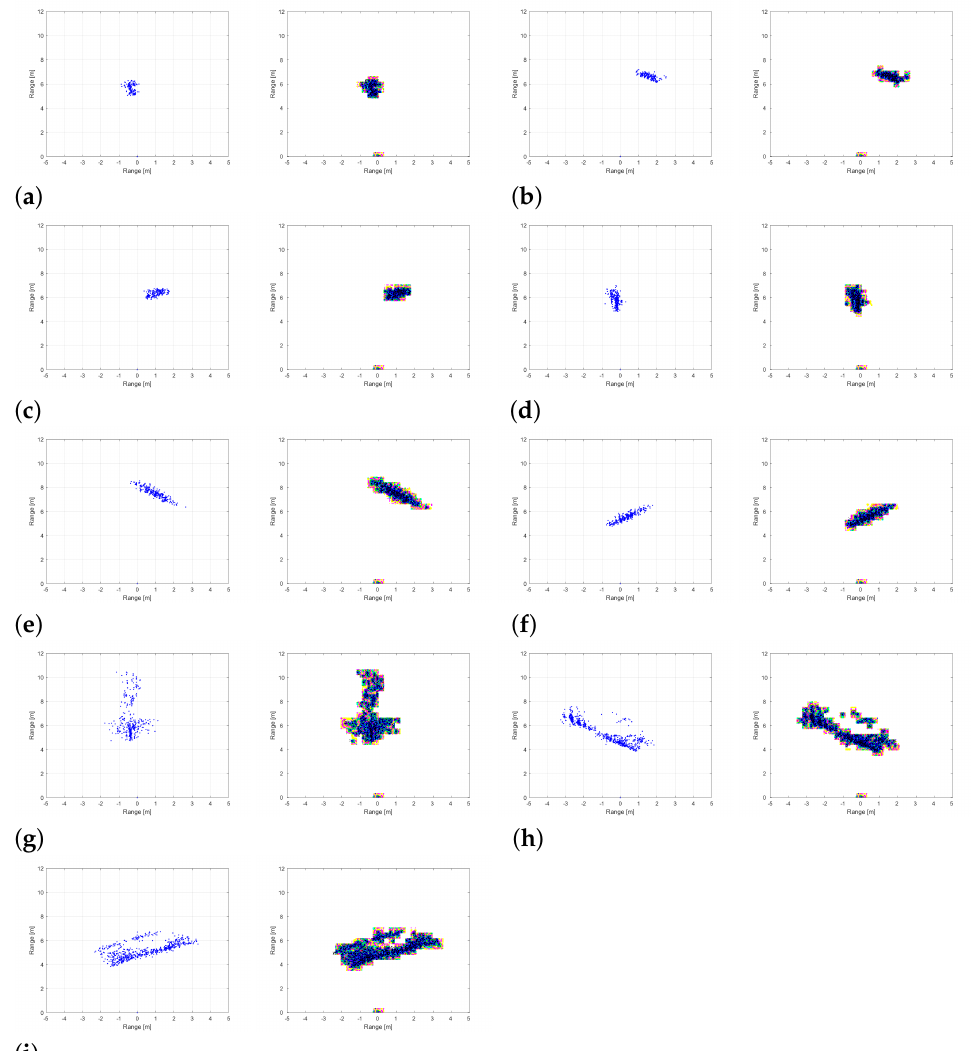
Figure 6. Regenerated detection results: ( a ) when a pedestrian goes straight ( b ) when a pedestrian moves from right to left ( c ) when a pedestrian moves from left to right ( d ) when a cyclist goes straight ( e ) when a cyclist moves from right to left ( f ) when a cyclist moves from left to right ( g ) when a car goes straight ( h ) when a car moves from right to left ( i ) when a car moves from left to